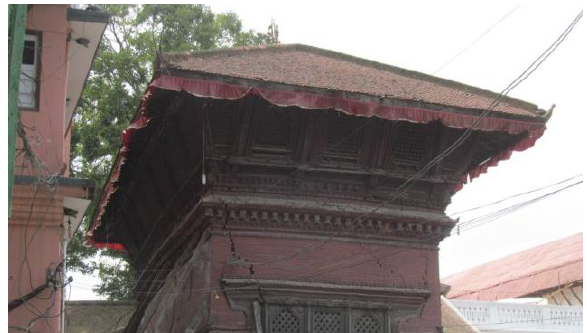
Figure 1. Effects caused by 2015Ghorka